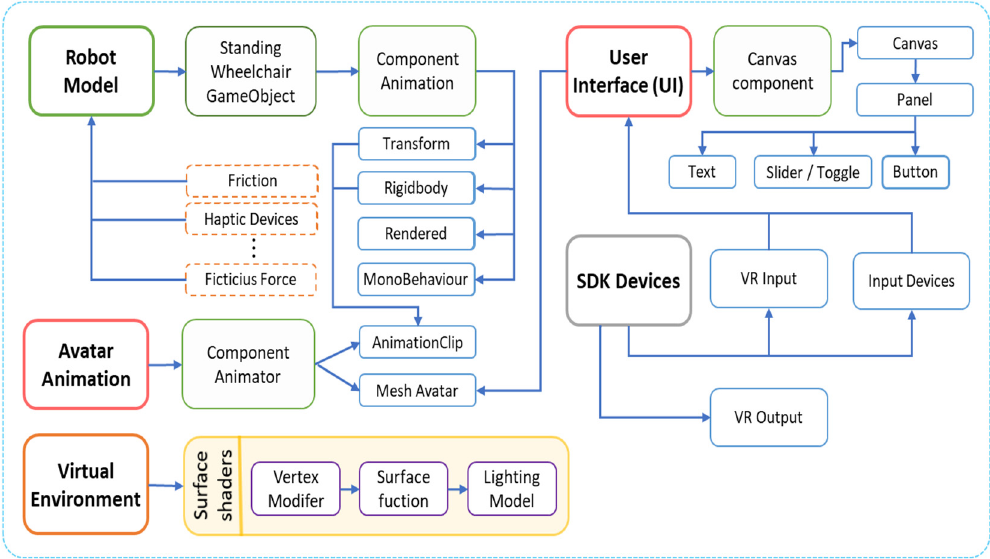
Figure 10. Scripting general scheme.